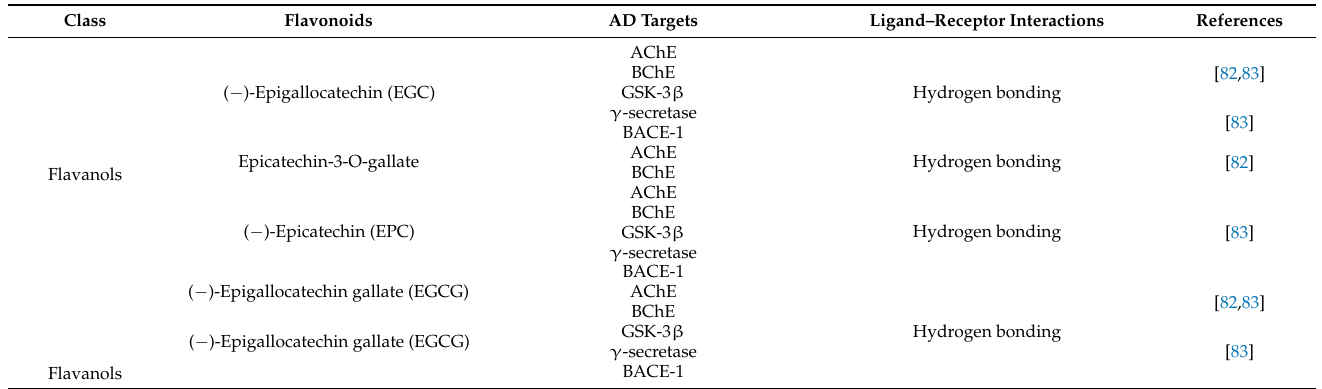
Table 2. Favorable effects of flavonoids against different AD targets in